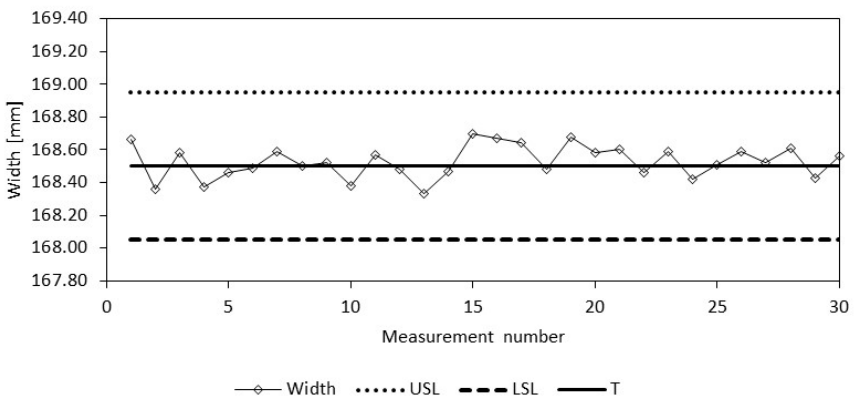
Figure 9. Shewhart control chart individual values for the width parameter, second day.